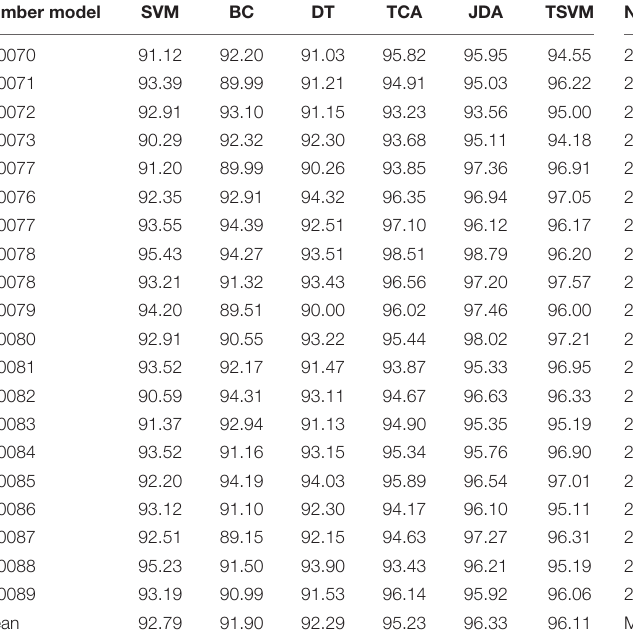
TABLE 6 | TNR indicators of the different classifiers on the test dataset (in percent). Number